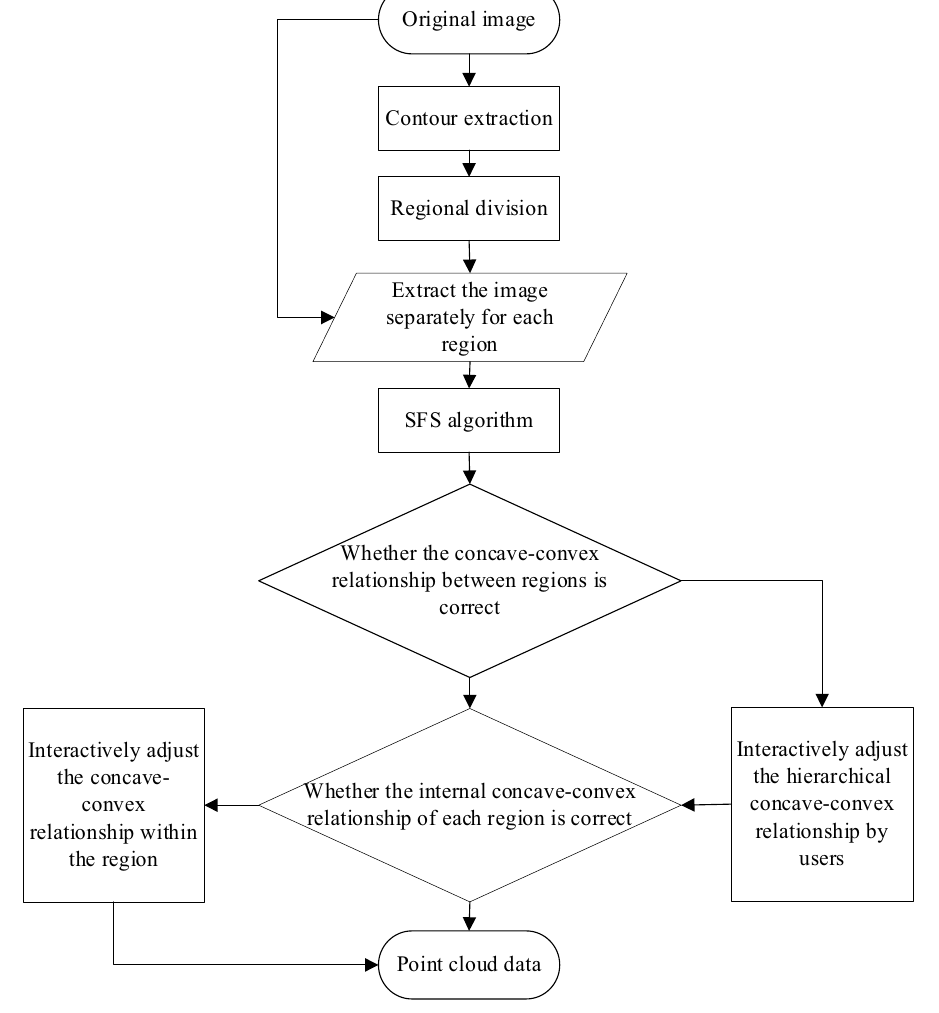
Figure 5. Flow chart of region-based image depth